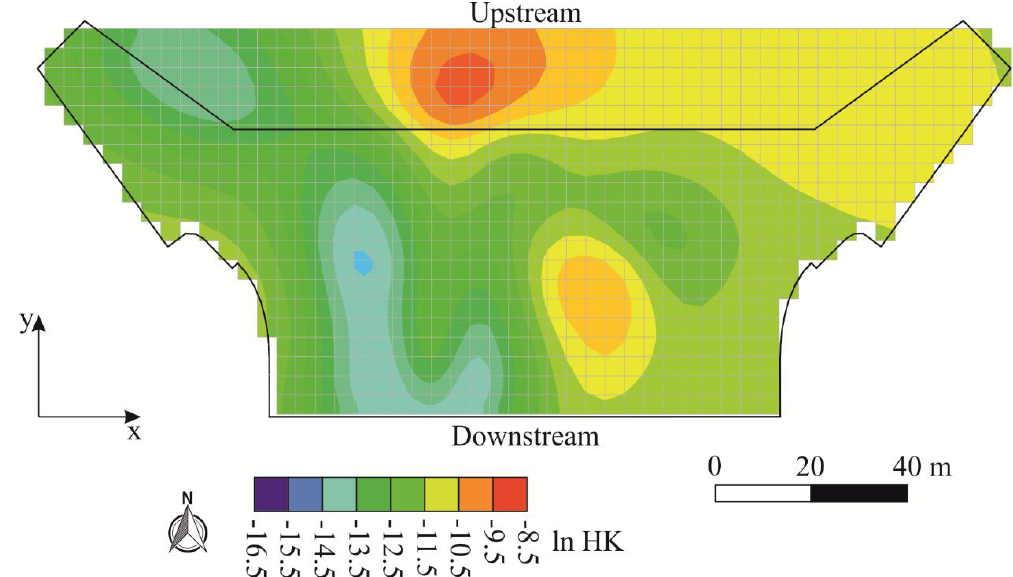
Figure 6. Estimated hydraulic conductivity field for layer 10: The results are reported in terms of natural logarithm of the parameters (ln HK) with units m/s in the physical space.